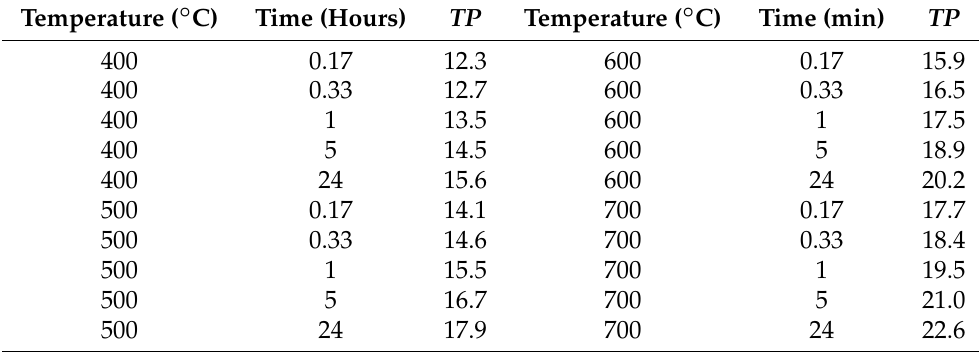
Table 2. Tested combinations of time and temperature. The tempering parameter TP was calculated using C = 20.